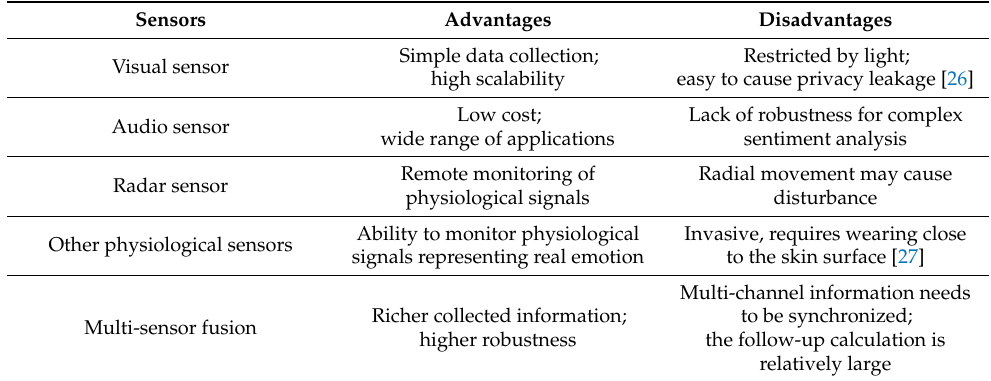
Table 1. Advantages and disadvantages of different sensors for emotion recognition.